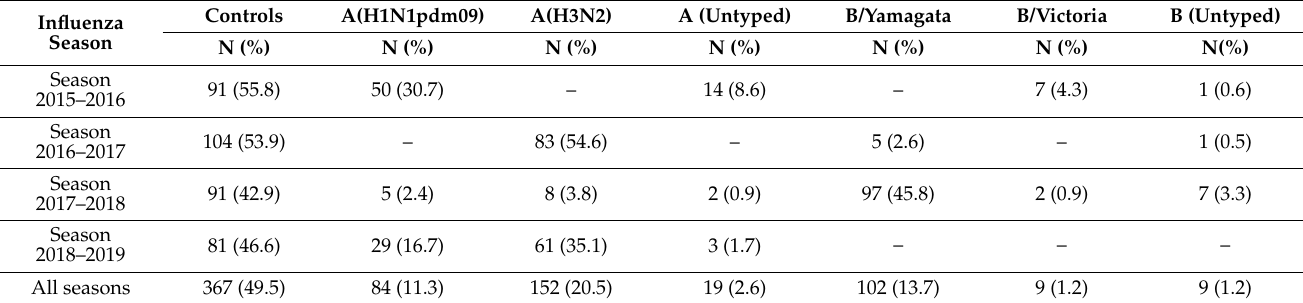
Table 2. Influenza types and subtypes in the total sample during the 2015–2019 influenza